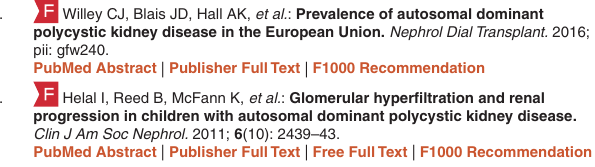
Many patients (though not all) will wish to be assessed for their eli- gibility for drug treatment or enrolment in clinical trials. Guidelines for managing patients are being developed in different countries 40–42